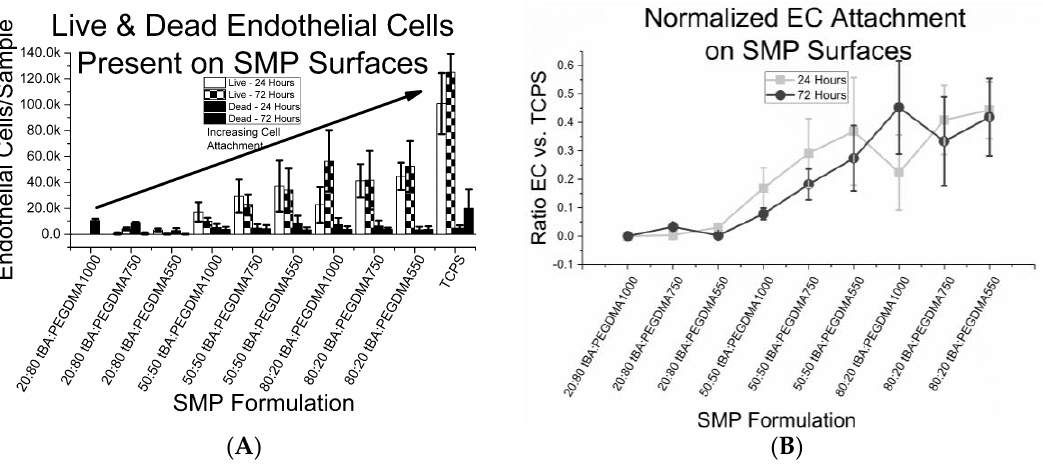
Figure 8. ( A ) cell count of human umbilical vein endothelial cell (HUVECs) present on each sample, scaled to size of the SMP sample. Living endothelial cells are present on sample containing at least 50 wt % tBA; ( B ) endothelial cell count of each SMP sample normalized to endothelial cell count of control sample (TCPS). While HUVECs attach to SMP surfaces, full coverage of SMP samples is yet to be achieved.